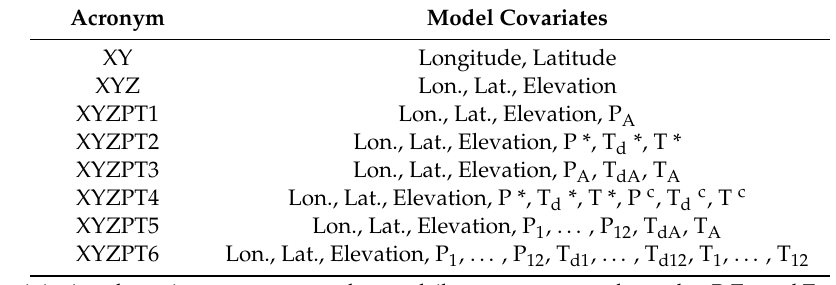
Table 1. Model acronyms and covariates employed.